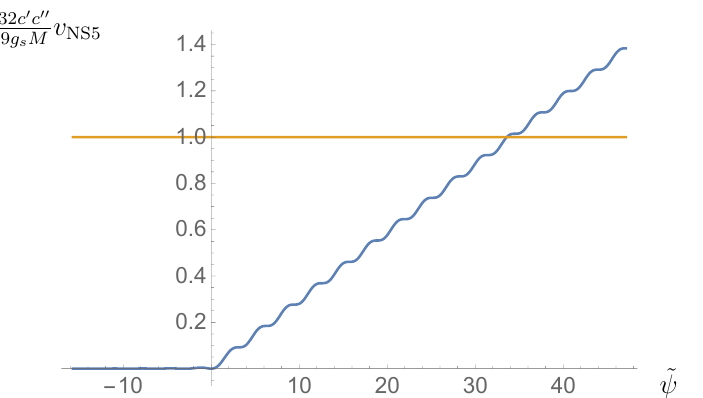
Figure 3 . The bound (3.4) constrains the allowed (cid:12)eld range of ~ . The maximum (cid:12)eld range is obtained where the yellow and blue line meet, here plotted for g s M =